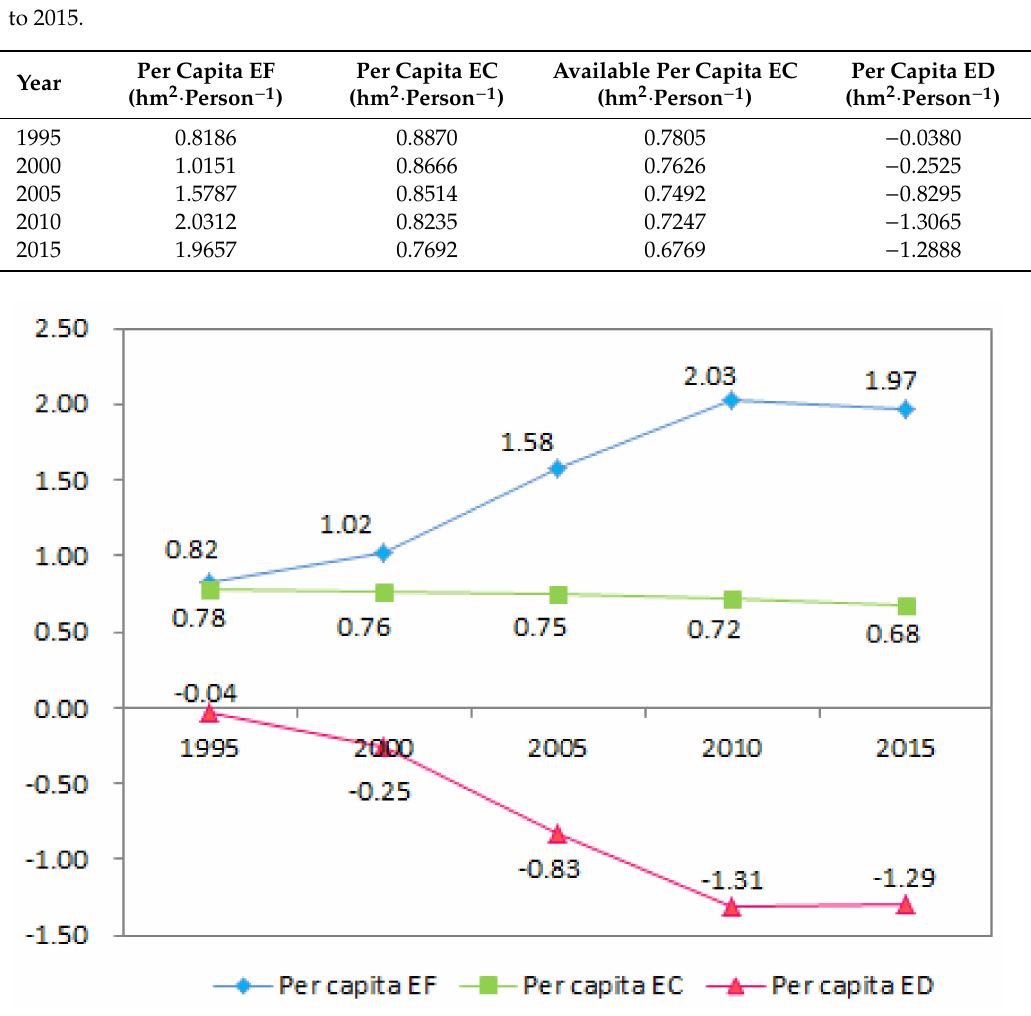
Figure 2. Per capita trends of EF, EC, and ED in northwestern Guangxi from 1995 to